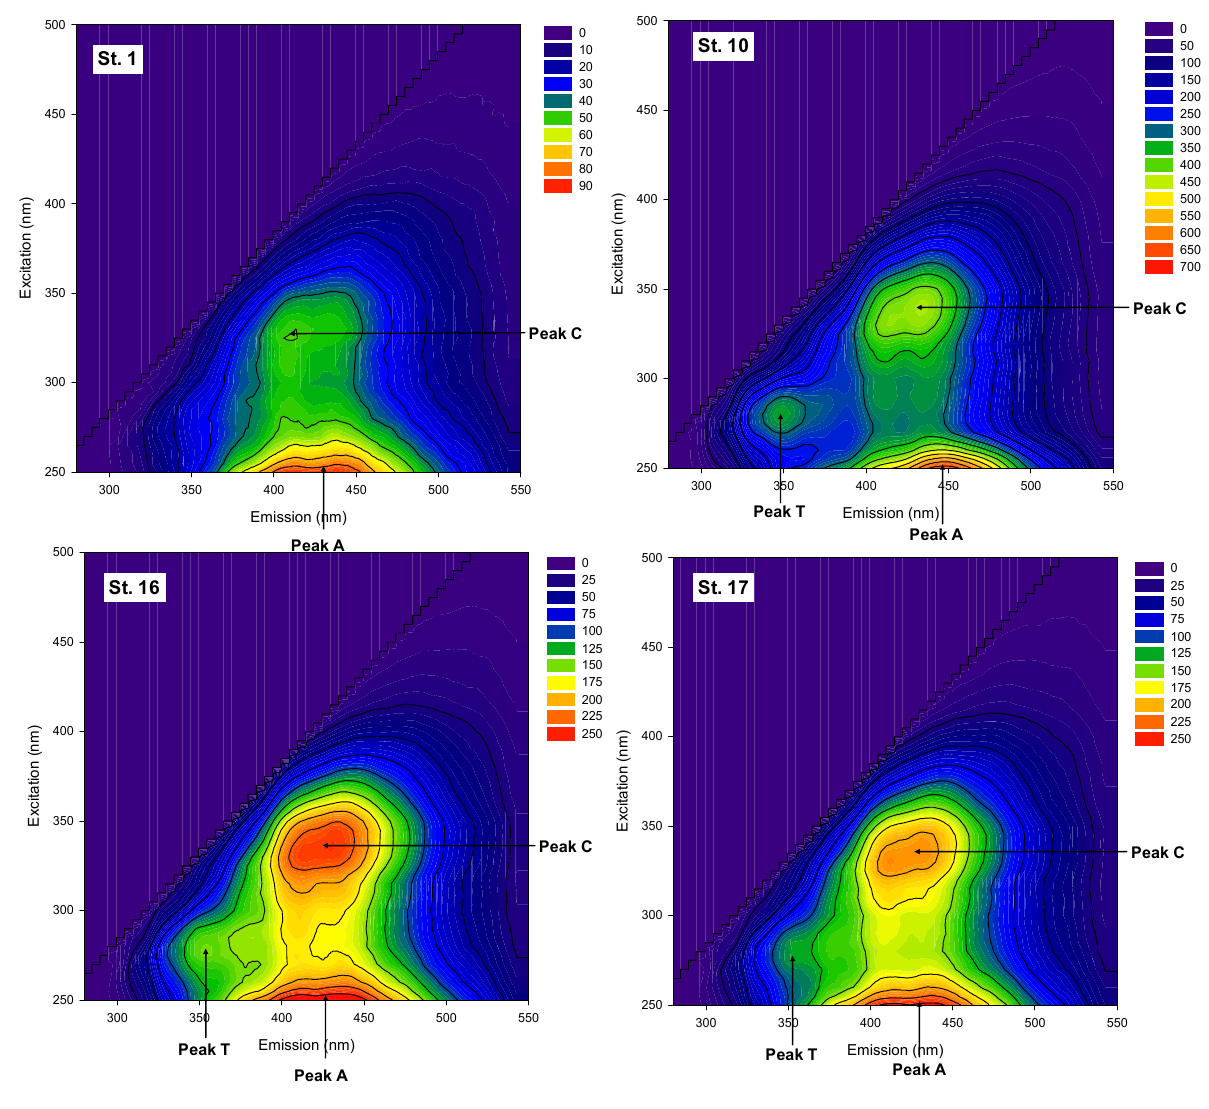
Figure 2. Fluorescence EEM spectra of the representative samples.